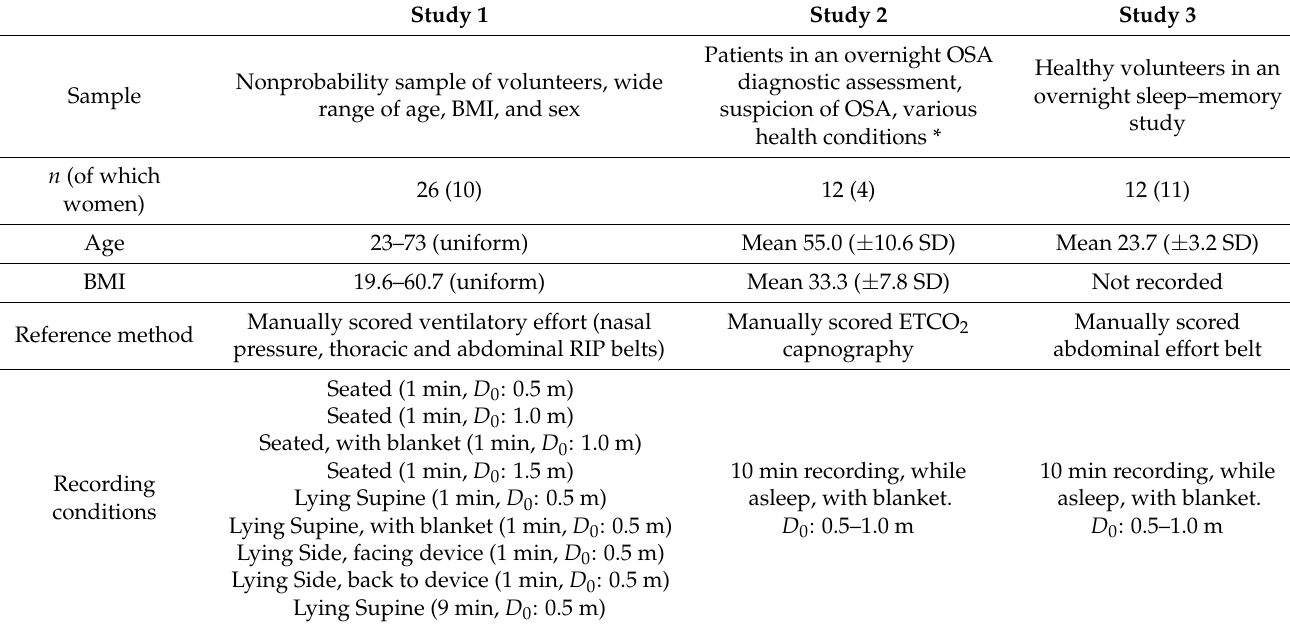
Table 1. Overview of subject populations and experimental conditions in Study 1, 2, and 3. Study 1 Study 2 Study